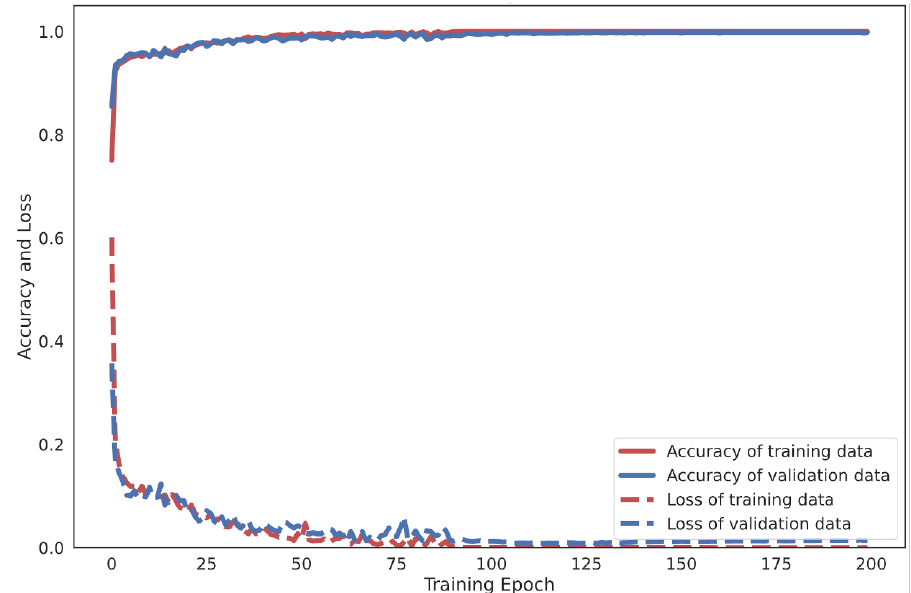
Figure 19. Accuracy and loss examples of training process of the proposed 4-layer CNN-LSTM.